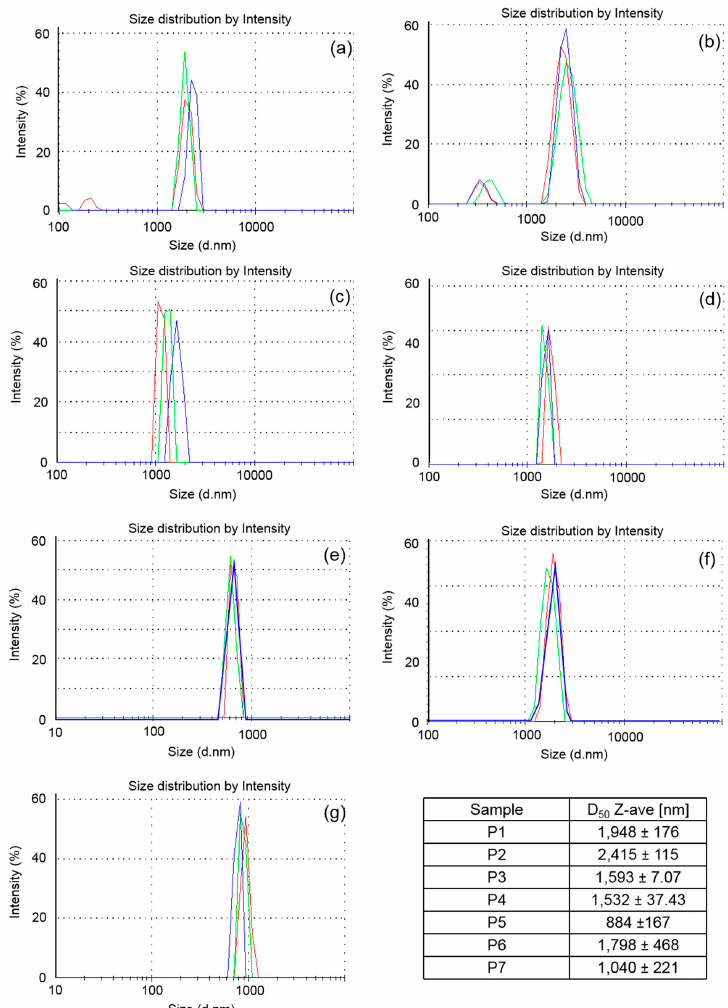
Figure 3. DLS spectra obtained for ( a ) P1; ( b ) P2; ( c ) P3; ( d ) P4; ( e ) P5; ( f ) P6; ( g ) P7 and average particle sizes from three measurements for each sample.